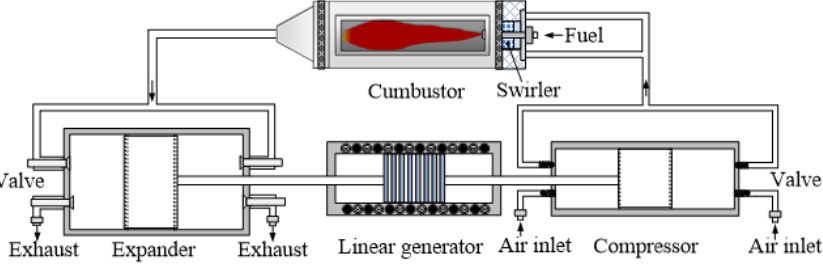
Figure 3. LEG system overview.